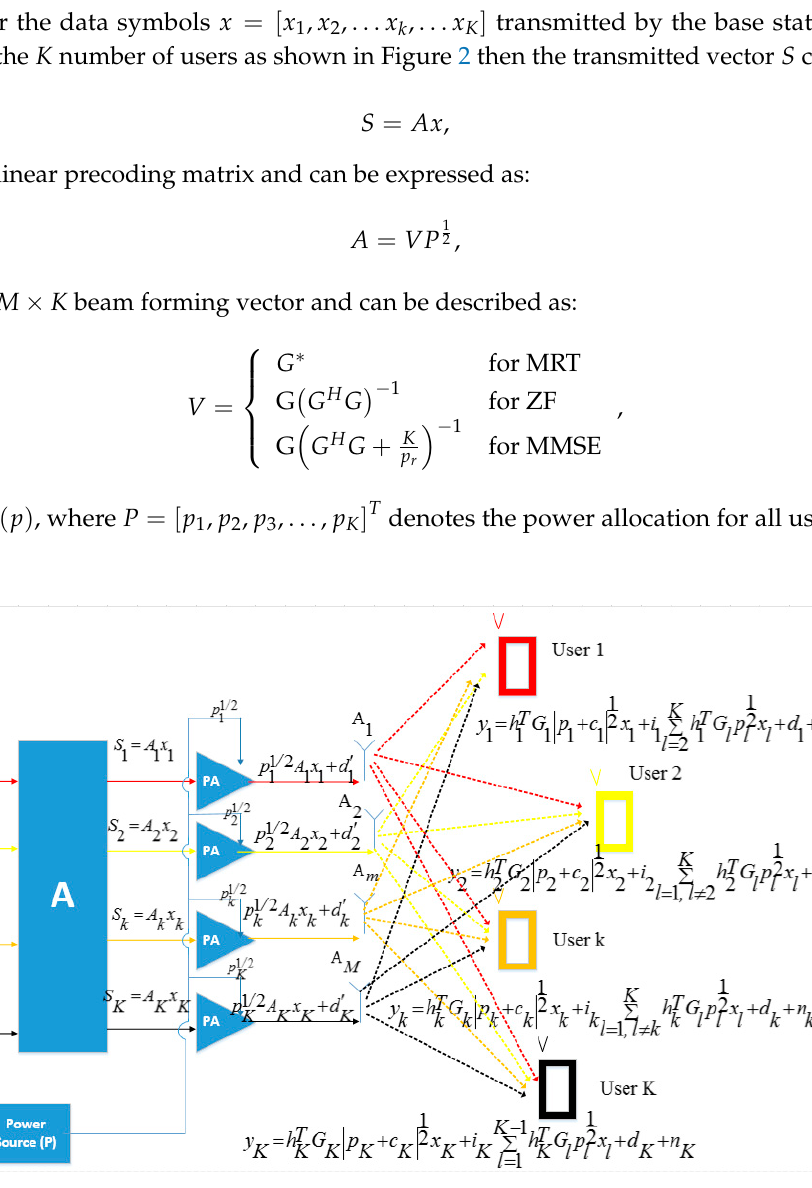
Figure 2. Block diagram of Massive MIMO with nonlinear amplifiers.